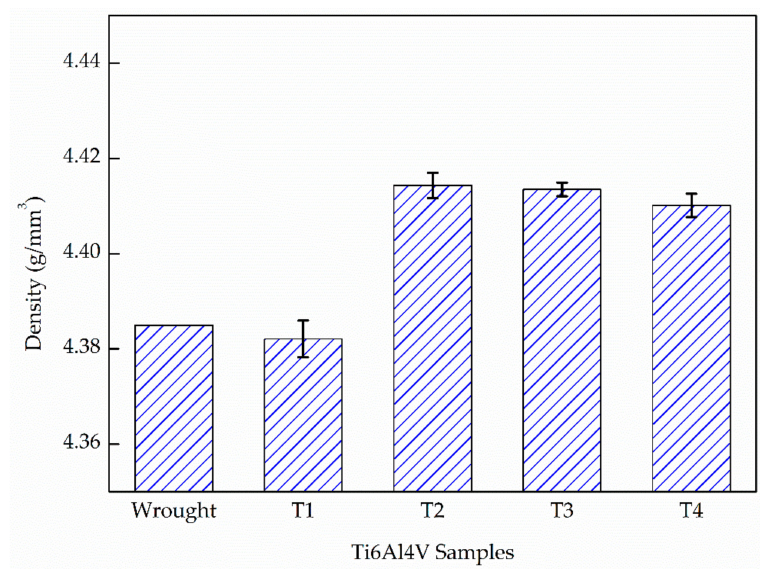
Figure 5. The density of the laser melting deposition-built samples compared with the wrought